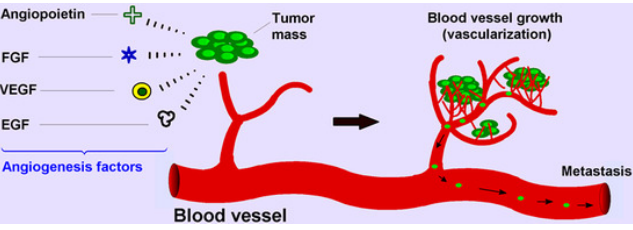
Figure 1. Depiction of the Tumor Angiogenesis